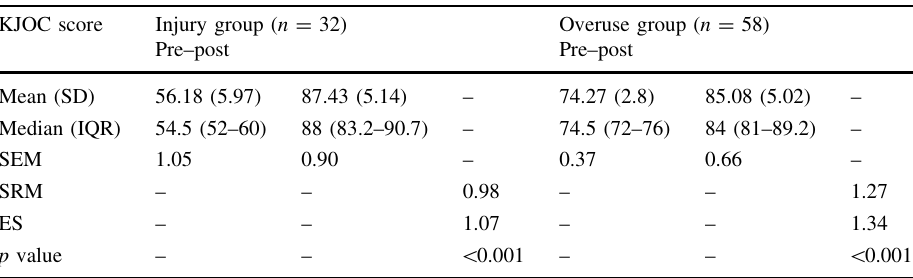
Table 4 Responsiveness of the Kerlan–Jobe Orthopaedic Clinic Shoulder and Elbow score in the injury and overuse